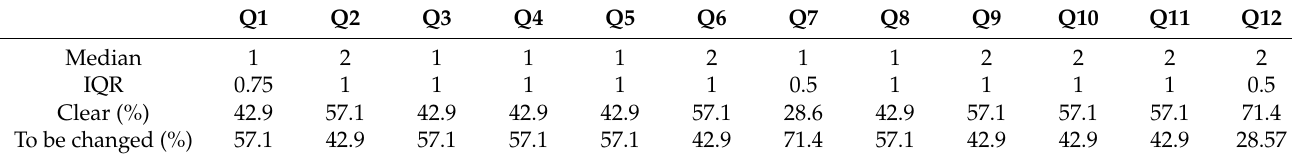
Table 1. Median and Interquartile Range (IQR) are presented for each question of the survey. The percentage of respondents indicating each item as “Clear” (i.e., score = 2) or “To be changed” (i.e., cumulative percentage of scores 1 and 0) is also reported. Each question of the survey re- ferred to specific items of the SAFE (see the main text for further details): Q1, instructions; Q2, visual subscale—visual fixation item; Q3, visual subscale—visual pursuit item; Q4, motor subscale— object manipulation item; Q5, motor subscale—automatic motor response item; Q6, oromotor-verbal subscale—intelligible verbalization item; Q7, communication subscale—non-functional intentional and functional appropriate items; Q8, motor subscale—noxious stimulation item; Q9, auditory subscale—non-object related reproducible movements to command and consistent movement